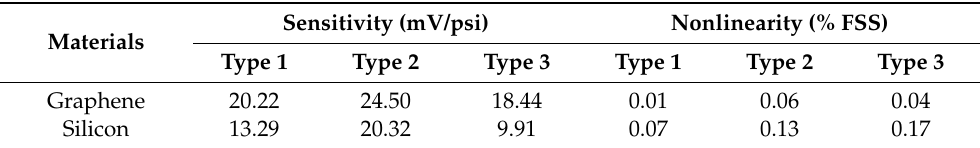
Figure 13. The impact of three different serpentine-shaped piezoresistors and two sensing materials on the significant sensor properties, respectively: ( a ) the effects on sensitivity and ( b ) nonlinearity. Table 8. Sensor characteristics for different types of graphene piezoresistors and silicon piezoresistors.